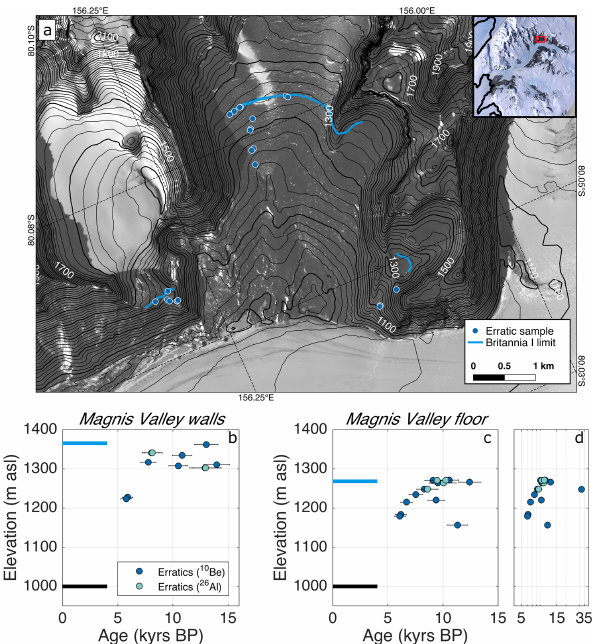
Figure 3. (a) Simplified map and sample locations at Magnis Valley. Blue curves indicated the mapped Britannia I (LGM) limit. Con- tours and satellite imagery from LINZ (2010), sourced from NZ- Topo Database, Crown Copyright Reserved. This product (LINZ Darwin Glacier orthophotos) incorporates data which are ©Japan Aerospace Exploration Agency (“JAXA”) 2008. Inset imagery from Bindschadler et al. (2008). (b, c) Mean surface exposure ages with total uncertainty at 1 standard deviation from valley walls and valley floor. Hatherton Glacier reached its limit in Magnis Valley ≤ 14ka and began to retreat at 7–8ka. The horizontal black line shows the elevation of the present-day glacier margin; horizontal blue lines show approximate elevations of the Britannia I limit at each loca- tion. (d) Valley floor ages on a log scale in order to show a single sample with significant prior exposure to cosmic rays.